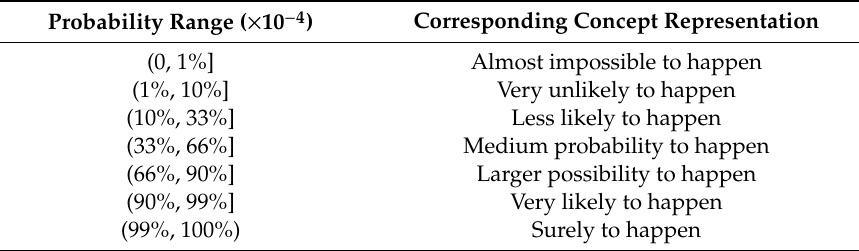
Table 2. Probabilistic characterization of the IPCC (Intergovernmental Panel on Climate